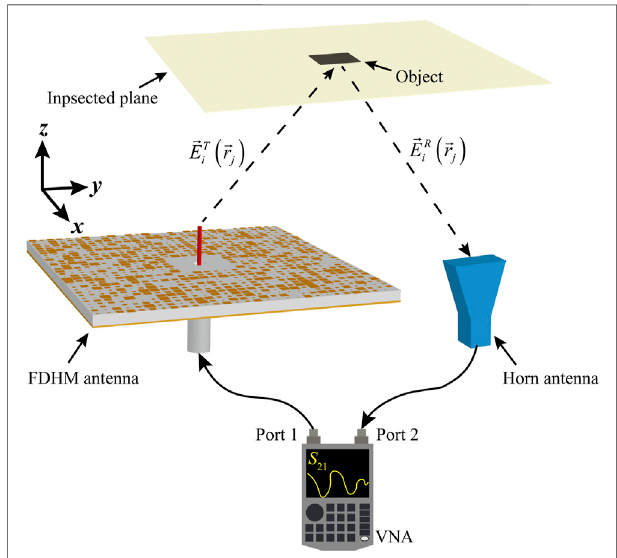
FIGURE 2 | Near- fi eld microwave CI system based on the FDHM antenna and CS theory.